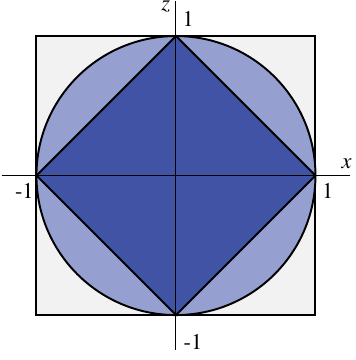
FIG. 2. Phasediagramforthefamiliesofstates ~ ρ ð x; y Þ ofEq.(38), with x; y ∈ R . The medium-shaded area shows the physical states; the dark-shaded area shows the states classified as noncontextual by Theorem 3. The states classified as contextual by Theorem 4 lie outside the square of j x j ; j z j ≤ 1 and are thus not